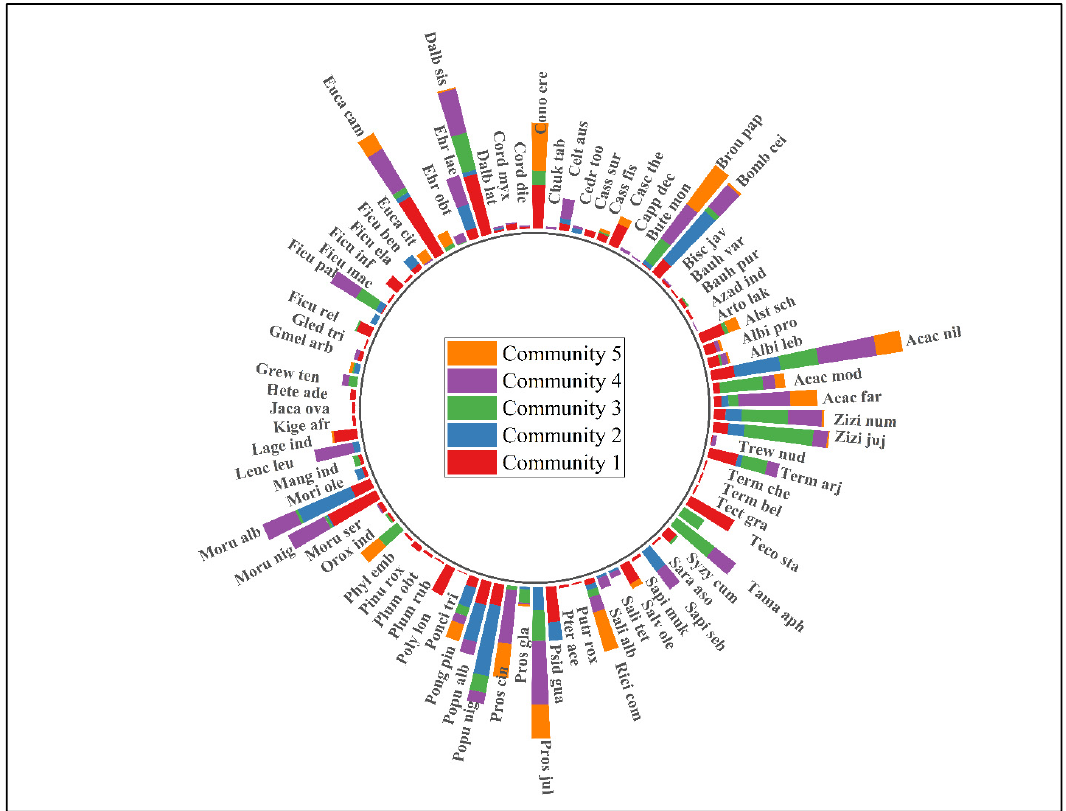
Figure 6. Radial stack bar plot showing the IV of woody species in different communities recorded from semi-arid lowland Kasur Punjab, Pakistan.